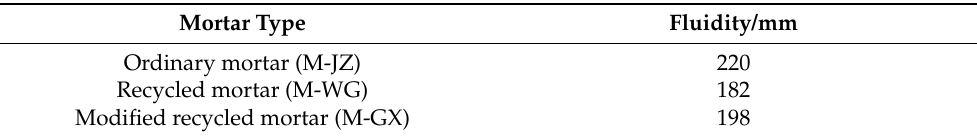
Table 3. The fluidity of ordinary mortar (M-JZ), recycled mortar (M-WG) and modified recycled mortar (M-GX). Mortar Type Fluidity/mm Ordinary mortar (M-JZ) 220 Recycled mortar (M-WG) 182